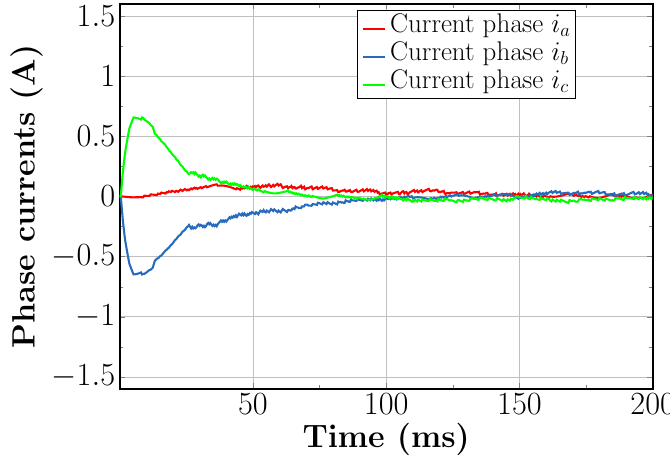
Figure 25. Sensorless speed control for 100 RPM, stator currents in stationary frame.